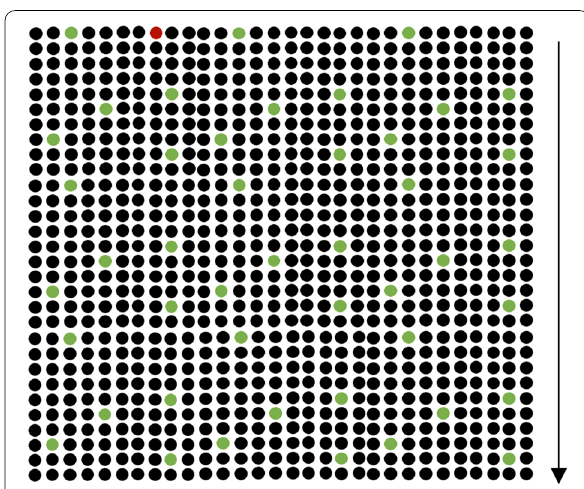
Fig. 3 Relative risk, where 1 (red dot) in 900 experiences a side effect and 1 (green) in 20 lives is saved by the treatment. The relative-risk icon array in Experiment 2 contained 1 million dots that participants had to scroll through if assigned to a visualization condition. The arrow on the right represents how participants had to scroll through the array of dots, but this arrow was not part of the original